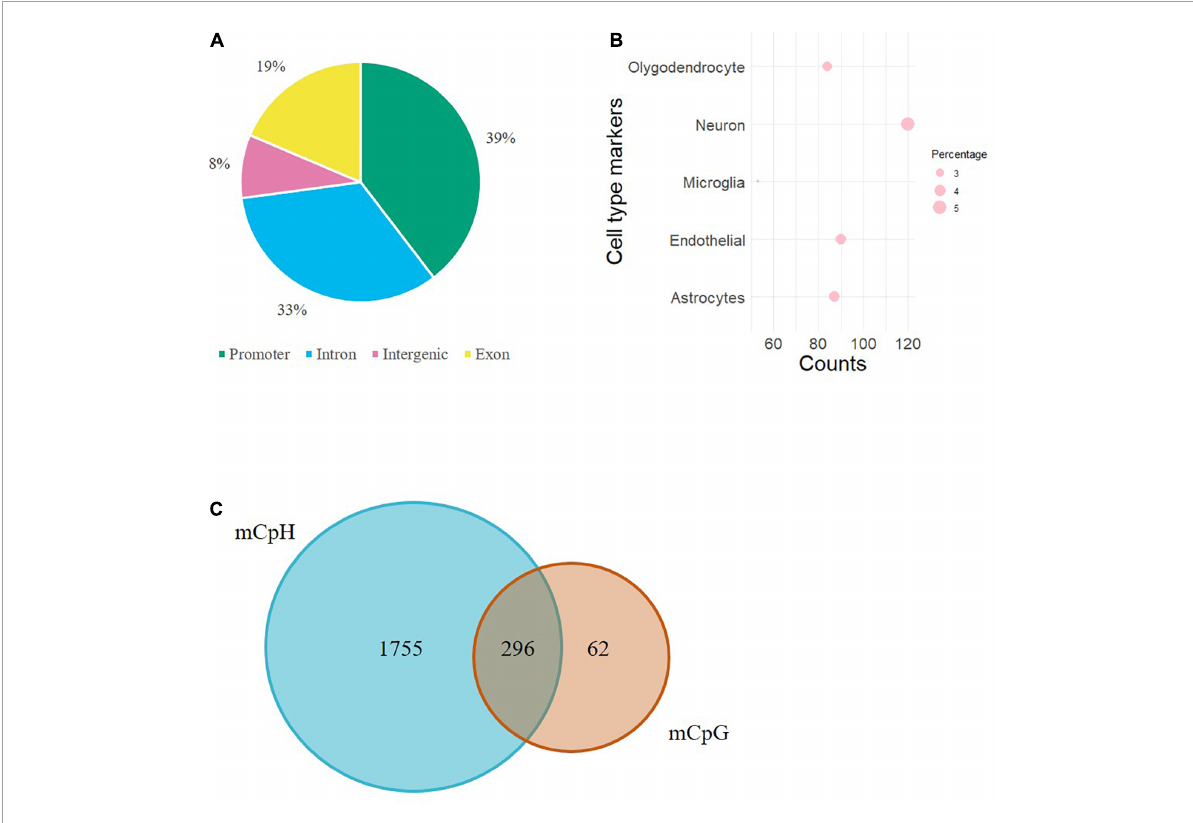
FIGURE1 Evaluation of differential mCpHs associated with OUD. (A) Genomic location of differential mCpHs. (B) Cell-type enrichment of differential mCpHs sites. (C) Venn diagram showing the comparison between differential mCpHs and mCpGs.